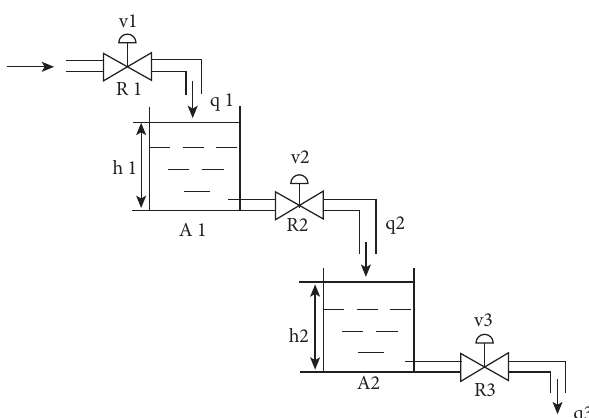
Figure 5: Schematic diagram of dual-capacity water tank.